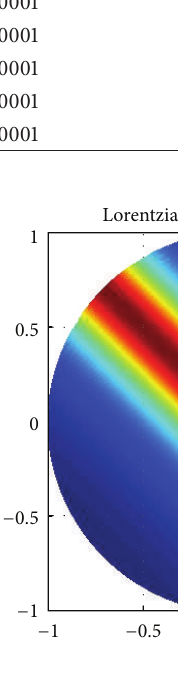
Table 10: Relation between the error E and the number of formal powers 𝑁 , when 𝜎 = ((𝑥 + 𝑦) 2 + 1) Number of radii 𝑅